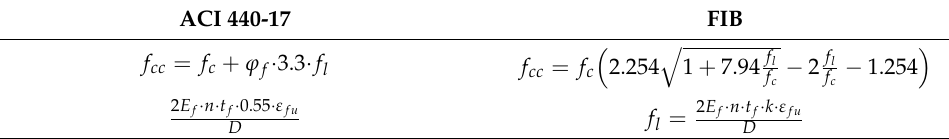
Table 1. ACI and FIB models for confined